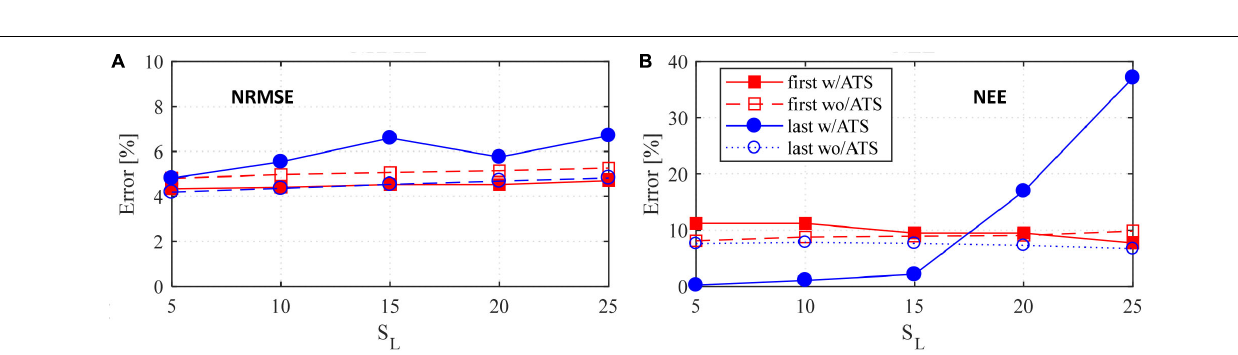
FIGURE 24 | RTHS (A) NRMSE and (B) NEE calculation for Model 1 (all geometric scales).